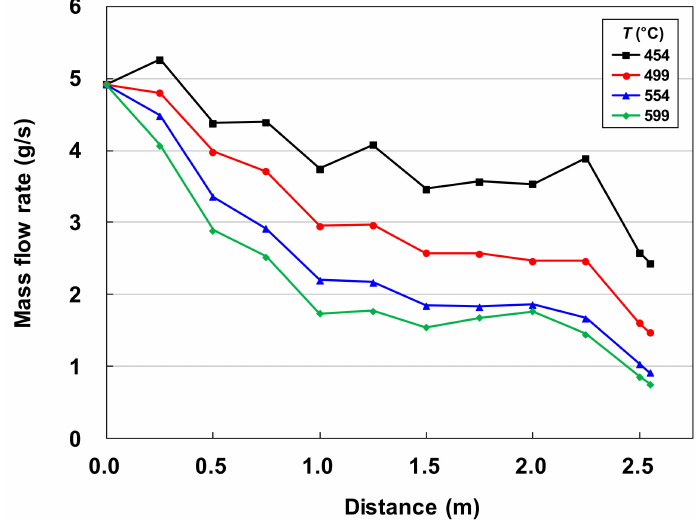
Figure 10. Mass flow rate of pyrolyzed particles along the distance from the top of the